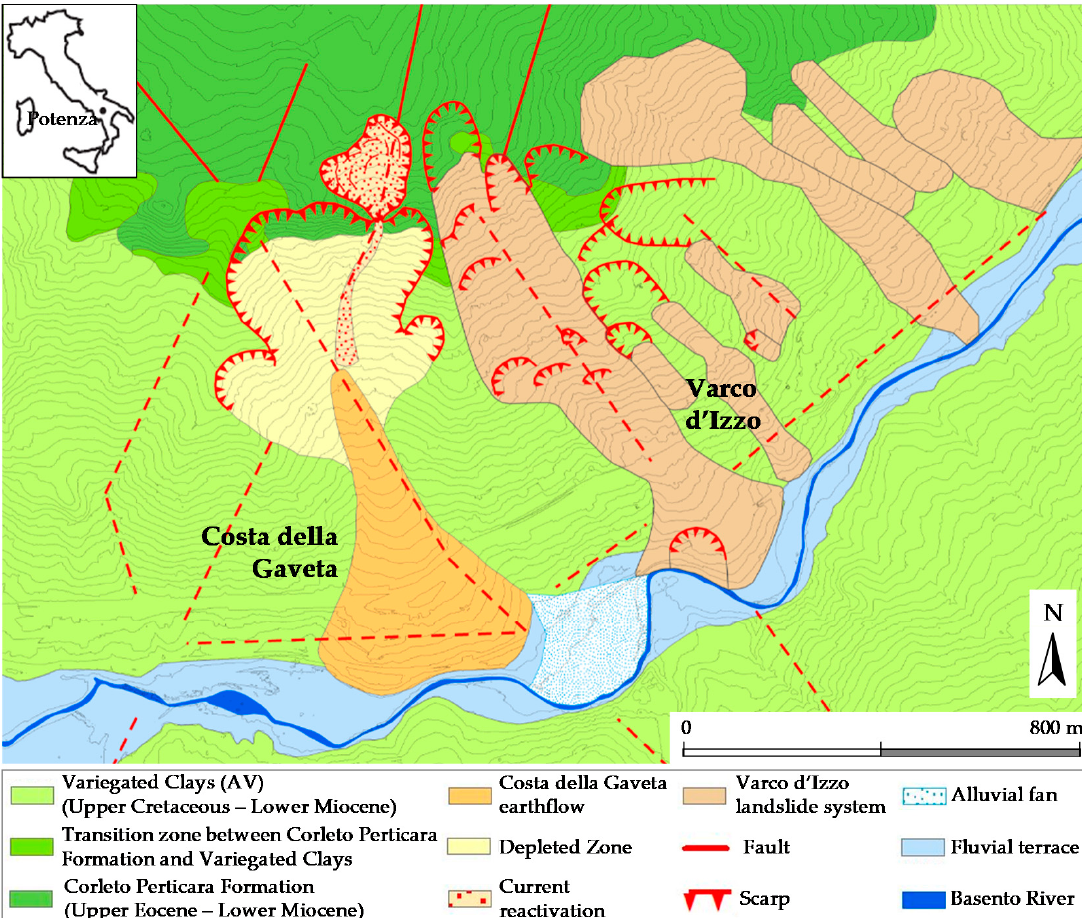
Figure 1. Geological map of the Costa della Gaveta earthflow (redrawn from [24]), and the Varco d’Izzo landslide system (redrawn from [26]).